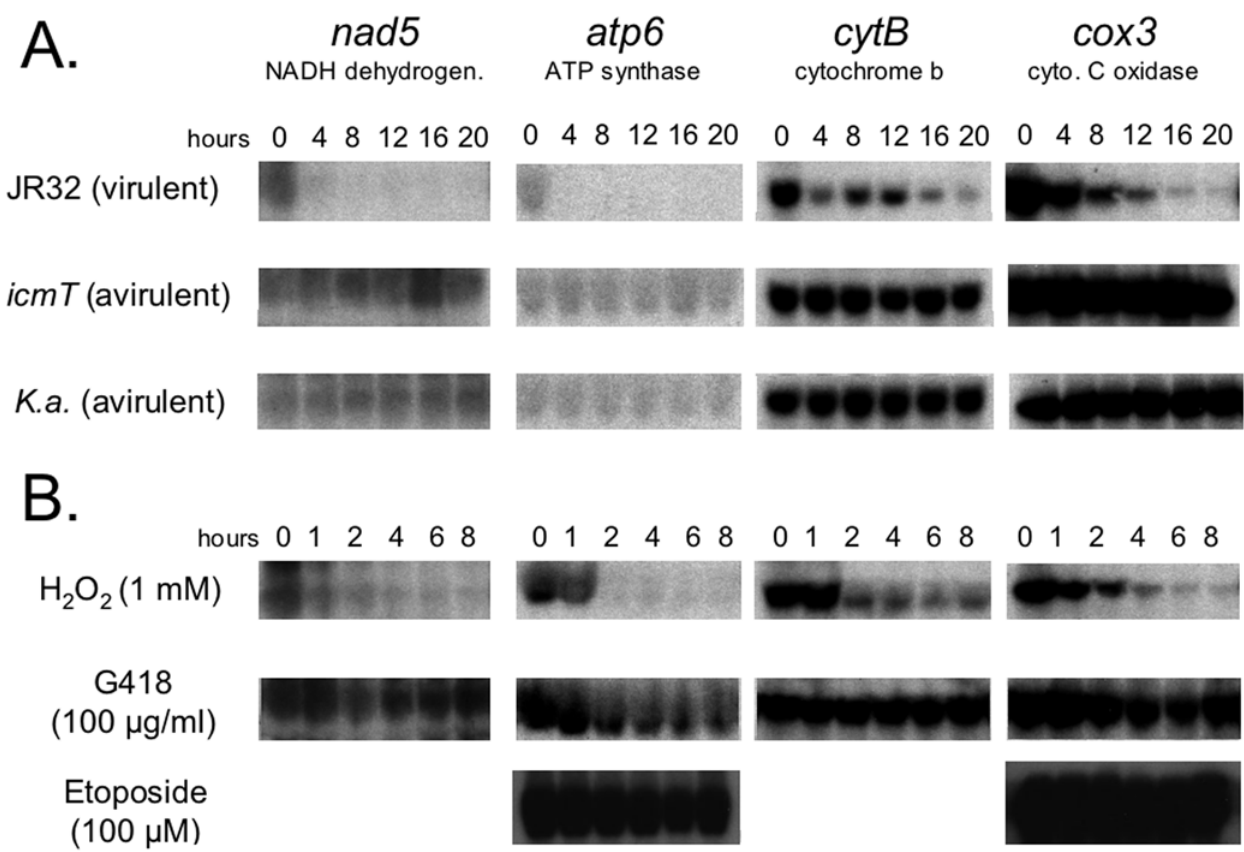
Figure 1. Decrease in D.discoideum mitochondrial mRNAs during L.pneumophila infection. (A) D. discoideum cells were infected with L. pneumophila (JR32) at an M.O.I. of 10 and RNA was extracted at the indicated times and analyzed on northern blots. Substantial cell death occurred after 8 hours in this experiment (data not shown). Messenger RNA for the mitochondrial-encoded genes examined displayed two modes of decline; rapid ( nad5 and atp6 ) and gradual ( cobA and cox3 ). As controls, cells were also exposed to avirulent L. pneumophila ( icmT mutant) or the food bacteria K. aerogenes . (B) The mRNA levels of these genes were also examined under conditions that kill D. discoideum cells by oxidative stress (hydrogen peroxide), inhibition of protein synthesis (G418, an aminoglycoside), inhibition of DNA synthesis (Etoposide, a topoisomerase II